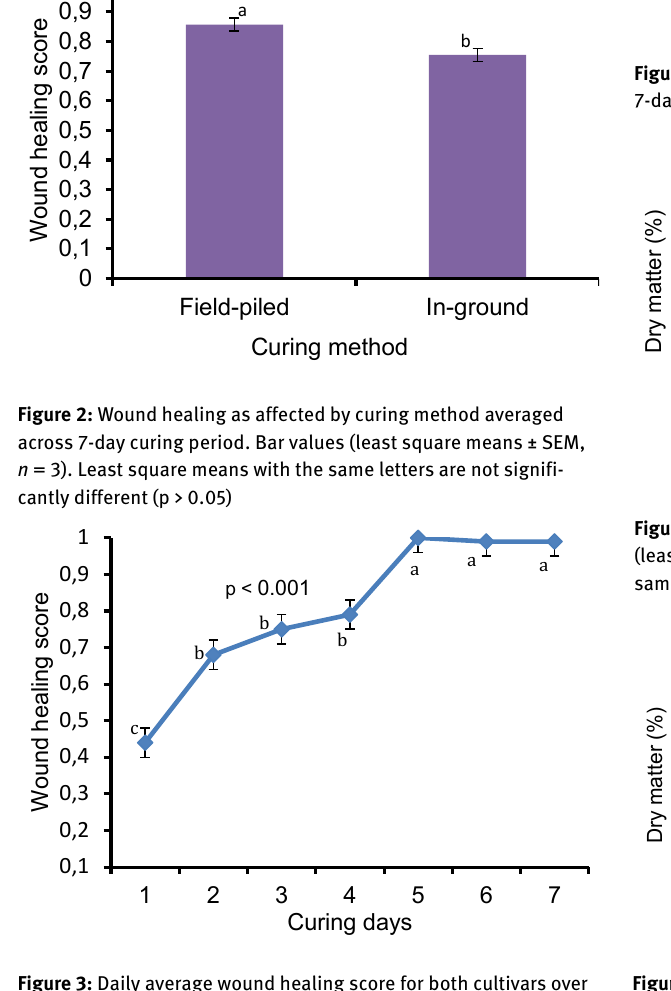
Figure 3: Daily average wound healing score for both cultivars over 7-day curing. Values are least square means ± SEM, n = 3. Least square means with the same letters are not significantly different (p >